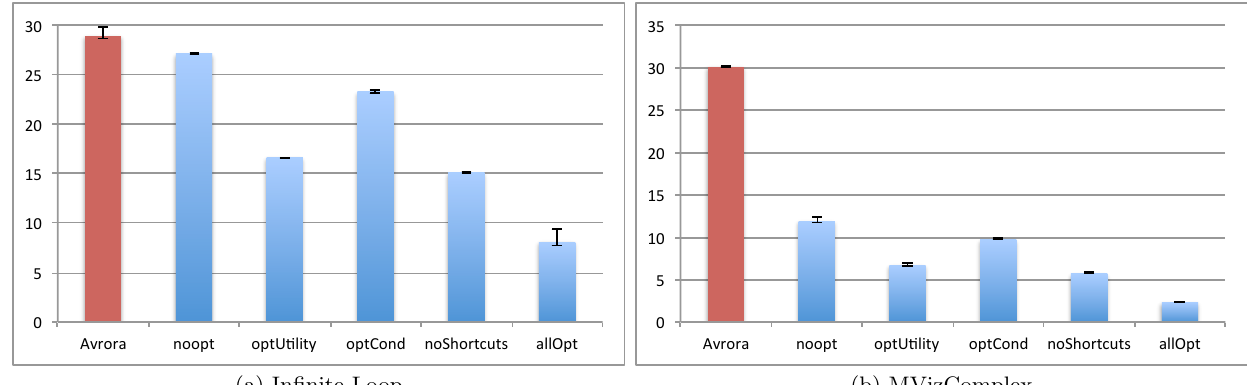
Figure 3: Single-node simulation performance (wall time in